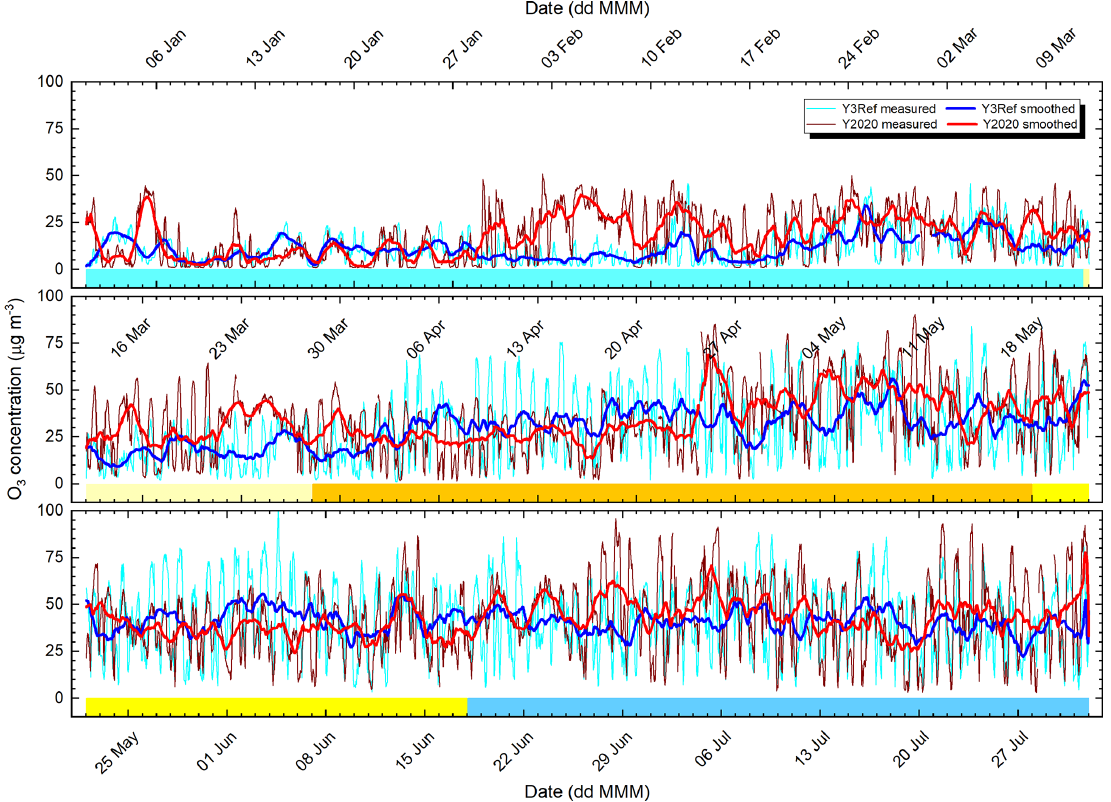
Figure 4. Time series of O 3 concentration in the average reference year comprising 2017–2019 (Y3Ref) and year 2020 together with their 24h smoothed curves over the five consecutive phases of the first COVID-19 outbreak. The phases are marked by the following colour codes: Pre-emergency phase lighter blue, Pre-restriction phase lighter yellow, Restriction phase orange, Post-restriction phase darker yellow and Post-emergency phase darker blue. The tick labels of the abscissa indicate the Mondays in